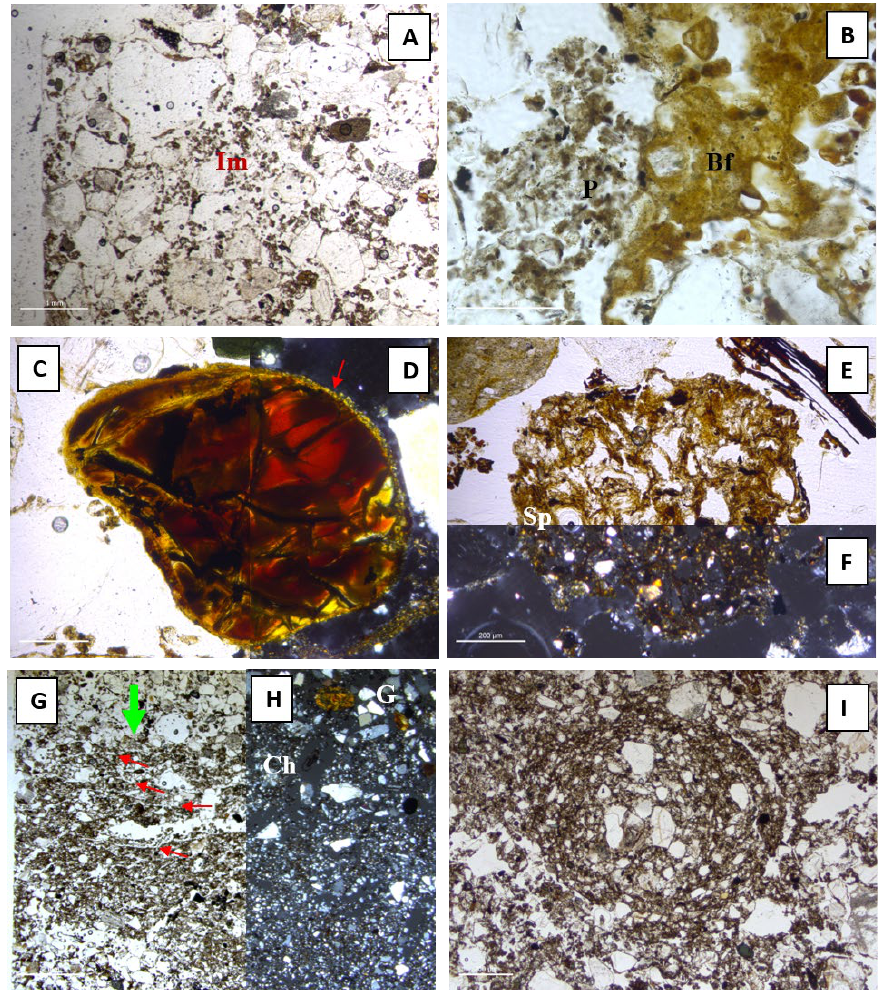
Figure 8. Microstructure and composition of the sediment deposits within the pit features at the Fort Odanak site (CaFe-7). ( A ) Sediments inside a pit feature showing a chitonic c/f related distribution with intergranular microaggregates (Im) of organic matter. The presence of collembolan and/or enchytraeid fecal pellets is visible in the plasma (Pit feature 12F50C, ⁓ 33 cm/surface, PPL). ( B ) Transition between a pit feature (P) and the natural B horizon of the surrounding sediments (Bf). Note the marked change of color and texture in the matrix. Plasma within the feature is granular and organic. The fine fraction of the natural sediments is dense, mineral and oxidized (Pit feature 12A64, ⁓ 58 cm/surface, PPL). ( C ) Goethite fragment inherited from the alluvial sediments of the Saint-François River. The mineral exhibits a fine coating of oxidized material (arrow) (Pit feature 12A57, ⁓ 55 cm/surface, PPL). ( D ) Same in XPL. Iron oxides in the mineral show strong interference. ( E ) Dropping left by mesofauna. Fecal material contains highly decomposed organic fragments, spores (Sp) and small mineral grains (Pit feature 12A72, ⁓ 60 cm/surface, PPL) ( F ) Same in XPL ( G ) Lamellar (isoband) microstructure in the compact silty deposit, resulting from freezing/thawing in the soil during a period of intense cold. Elongated planar voids (red arrows) parallel to each other appear distinctly in the groundmass. Channels (Ch) created by bioturbation are also visible. Note the clear transition between the chitonic sandy sediments and the porphyric silty deposit within the feature (green arrow) (Pit feature 12A64, ⁓ 58 cm/surface, PPL). ( H ) Same in XPL. Note the presence of two goethite (G) fragments in the coarse fraction of the sand. ( I ) Cryogenic rotational micro-feature in the silty deposit with a concentration of coarser grains in its centre (Pit feature 12A64, ⁓ 58 cm/surface, PPL). PPL, polarized microscope in plane-polarized light; XPL, crossed polarized light.